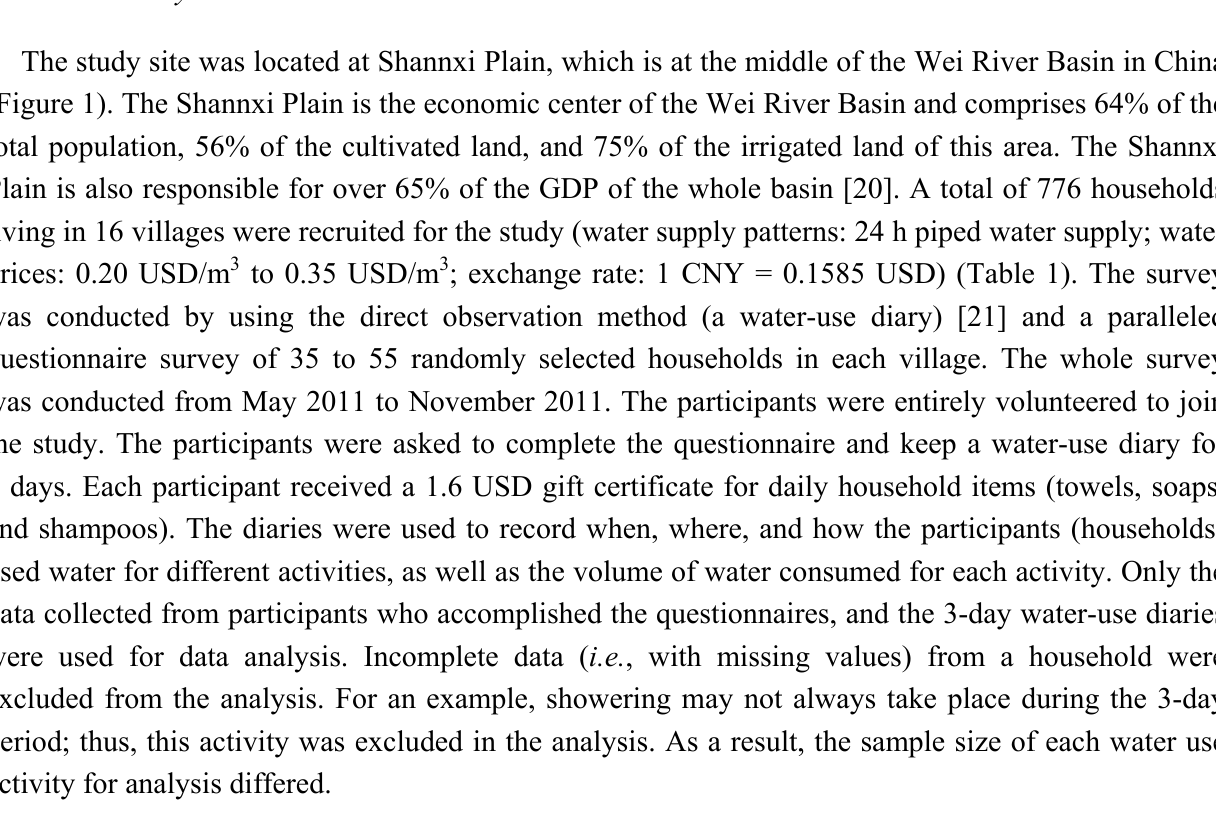
Figure 1. Location of the study region: ( a ) and ( b ) represent location of Wei River Basin and sample region; A, B and C represent sample region of Shannxi